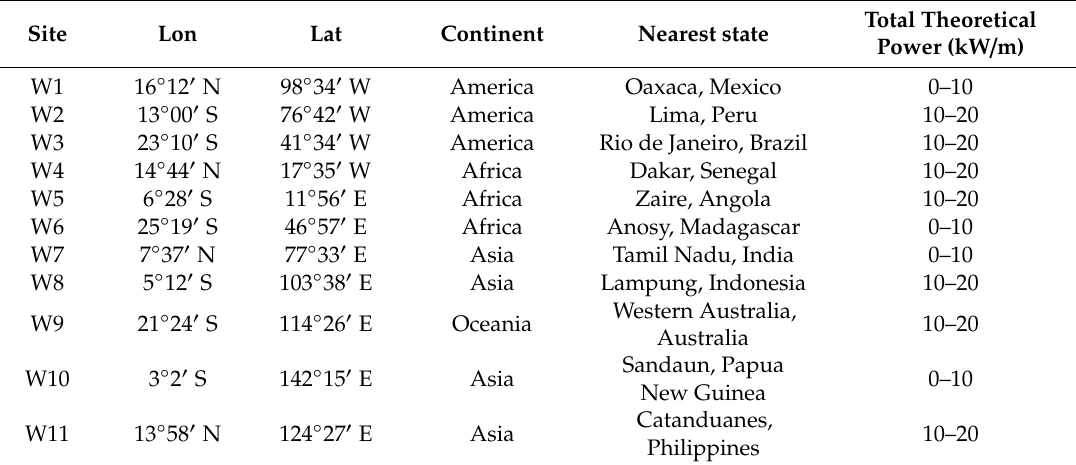
Table 1. The 11 sites analyzed to evaluate wave energy